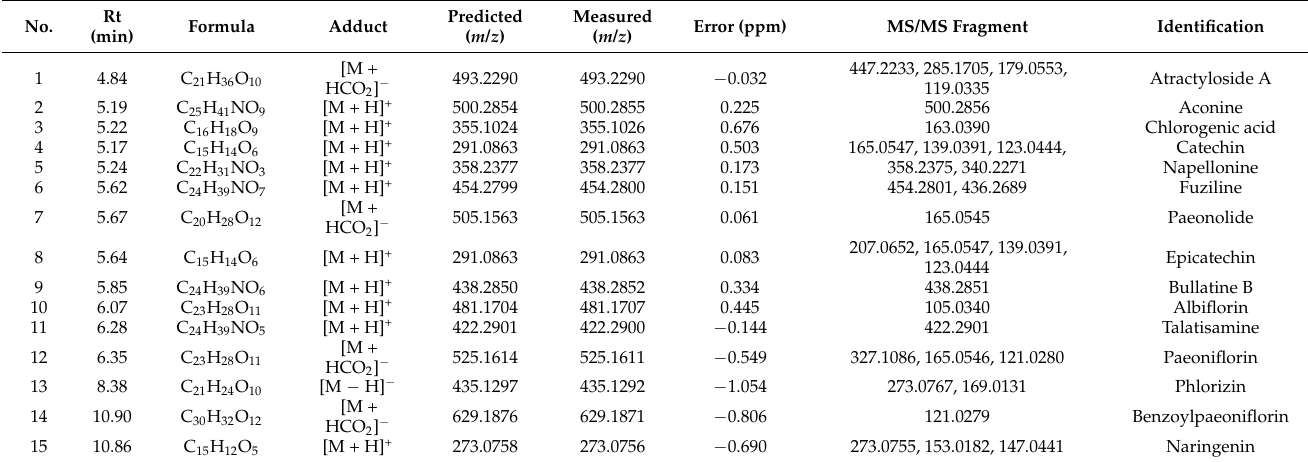
Figure 1. Representative base peak ion chromatograms of JMT extract by UHPLC-Q-Orbitrap-MS. The ID number of the various types of phytochemicals are listed in Table 1. Table 1. Characterization of identified compounds of JMT by